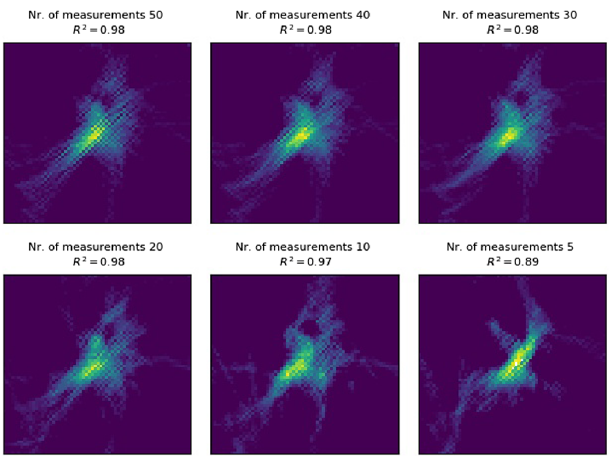
FIG. 7. The number of measurements used for the reconstruction is reduced, but the reconstructed shape stays equivalent.